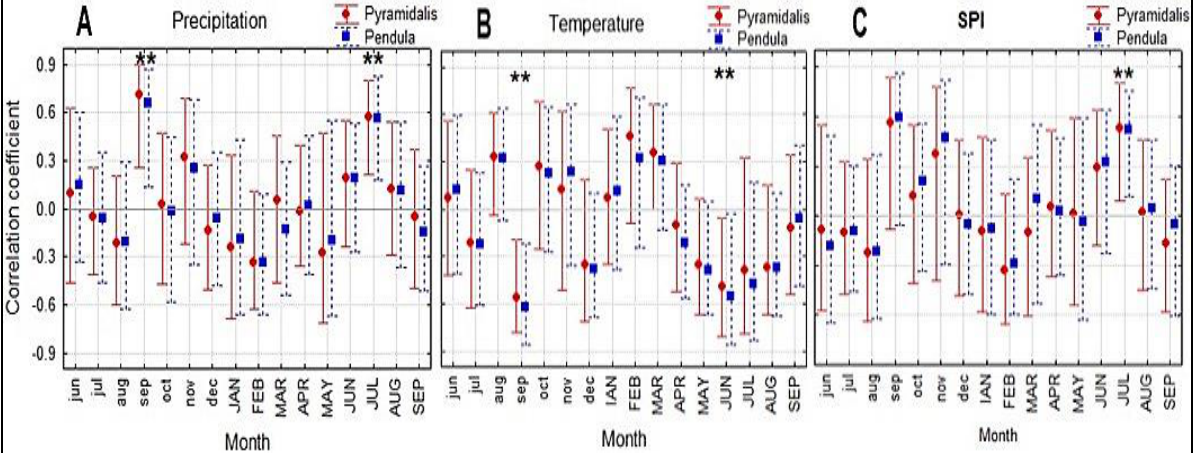
Figure 4. Comparison of correlation coefficients between monthly precipitation ( A ), temperature ( B ), and SPI ( C ) and the detrended ring-width series of the two Norway spruce forms ( pyramidalis and pendula ) for the 2001 – 2020 period. Months in lowercase letters refer to the previous year and in uppercase letters to the current year. Vertical lines represent the 95% confidence interval. *, significant correlations at p < 0.05.